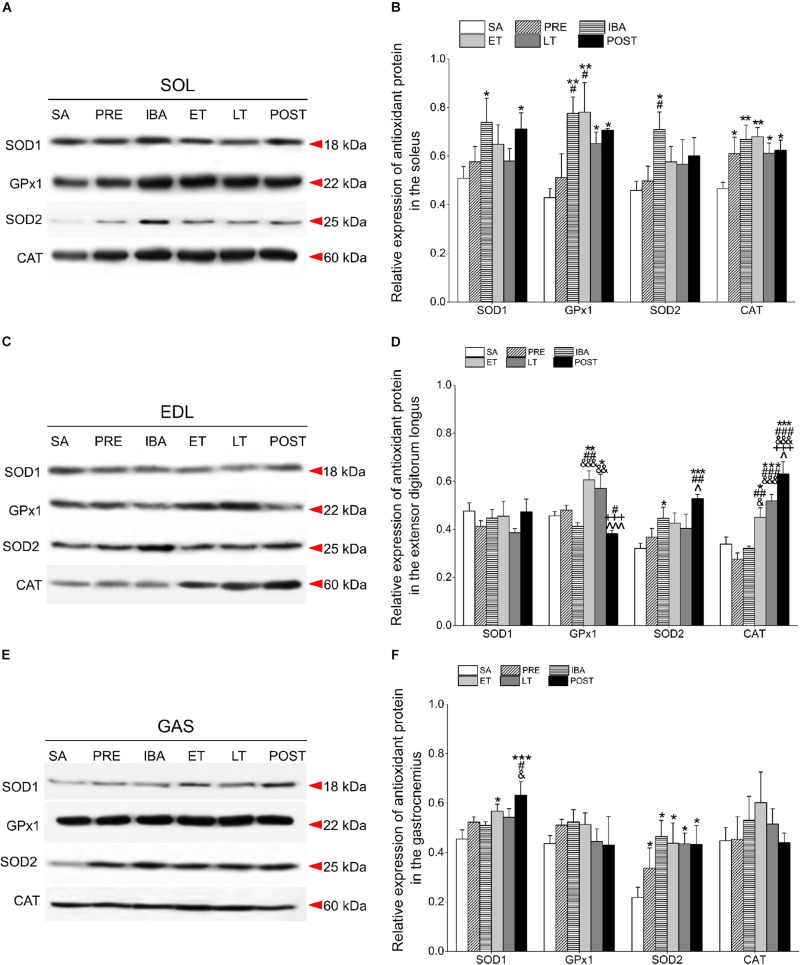
Changes in levels of SOD1, GPx1, SOD2, and CAT proteins in different skeletal muscles of Daurian ground squirrels over the torpor-arousal cycle. (A) Representative immunoblots of SOD1, GPx1, SOD2, and CAT in SOL during six hibernation periods. (B) Relative SOD1, GPx1, SOD2, and CAT protein expression in SOL. (C) Representative immunoblots of SOD1, GPx1, SOD2, and CAT in EDL during six hibernation periods. (D) Relative SOD1, GPx1, SOD2, and CAT protein expression in EDL. (E) Representative immunoblots of SOD1, GPx1, SOD2, and CAT in GAS during six hibernation periods. (F) Relative SOD1, GPx1, SOD2, and CAT protein expression in GAS. SA, summer active; PRE, pre-hibernation; IBA, interbout arousal; ET, early torpor; LT, late torpor; POST, post-hibernation. Values are means ± SEM, n = 8. ∗P < 0.05, Compared with SA; ∗∗P < 0.01, compared with SA; ∗∗∗P < 0.001, compared with SA; #P < 0.05, compared with PRE; ##P < 0.01, compared with PRE; ###P < 0.001, compared with PRE; &P < 0.05, compared with IBA; &⁣&P < 0.01, compared with IBA; &⁣&⁣&P < 0.001, compared with IBA; +++P < 0.001, compared with ET; ∧P < 0.05, compared with LT; ∧∧∧P < 0.01, compared with LT.